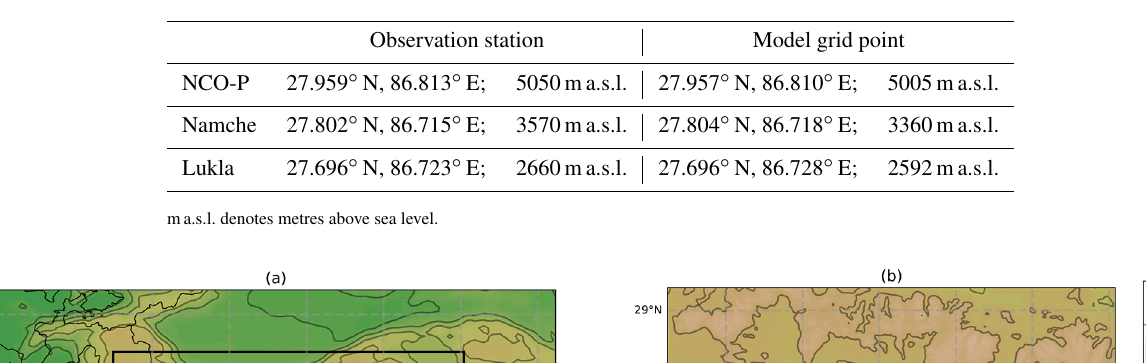
Table 1. Station and model grid point locations used in the comparison to observations.